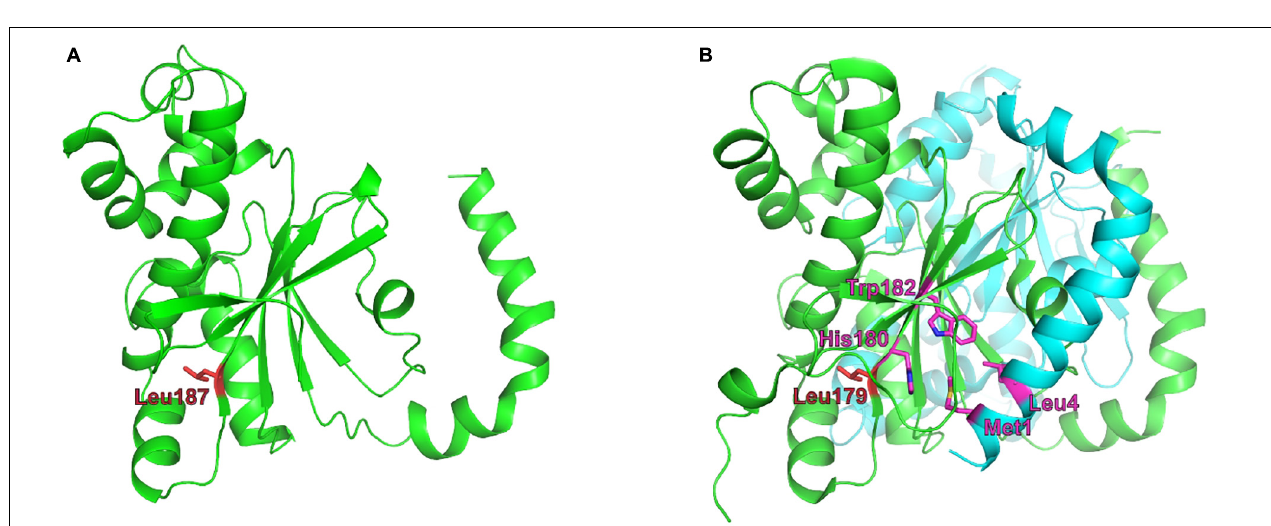
FIGURE 4 | Structural theoretical model of Brucella Ba2308 CAII. (A) Model structure of a monomer of Q2YLK1, the CA II from Brucella abortus 2308, created using Phyre2 and structure 5SWC from Synechocystis sp. as a template. Leu187 is depicted in red. (B) The X-ray structure of the Synechocystis sp. CA dimer, showing an equivalent leucine residue in position 179. Adjacent residues His180 and Trp182 from the C-terminal β -sheet are in close contact with residues Met1 and Leu4 from the N-terminal H1–H2 helix, respectively, and are involved in monomer–monomer interactions. Zinc atoms are depicted as pink